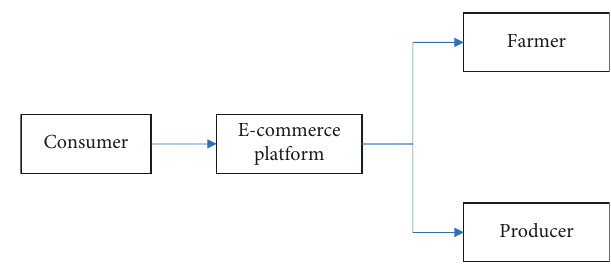
Figure 4: The main process of the B2C model. Table 1: Attribute values of linguistic